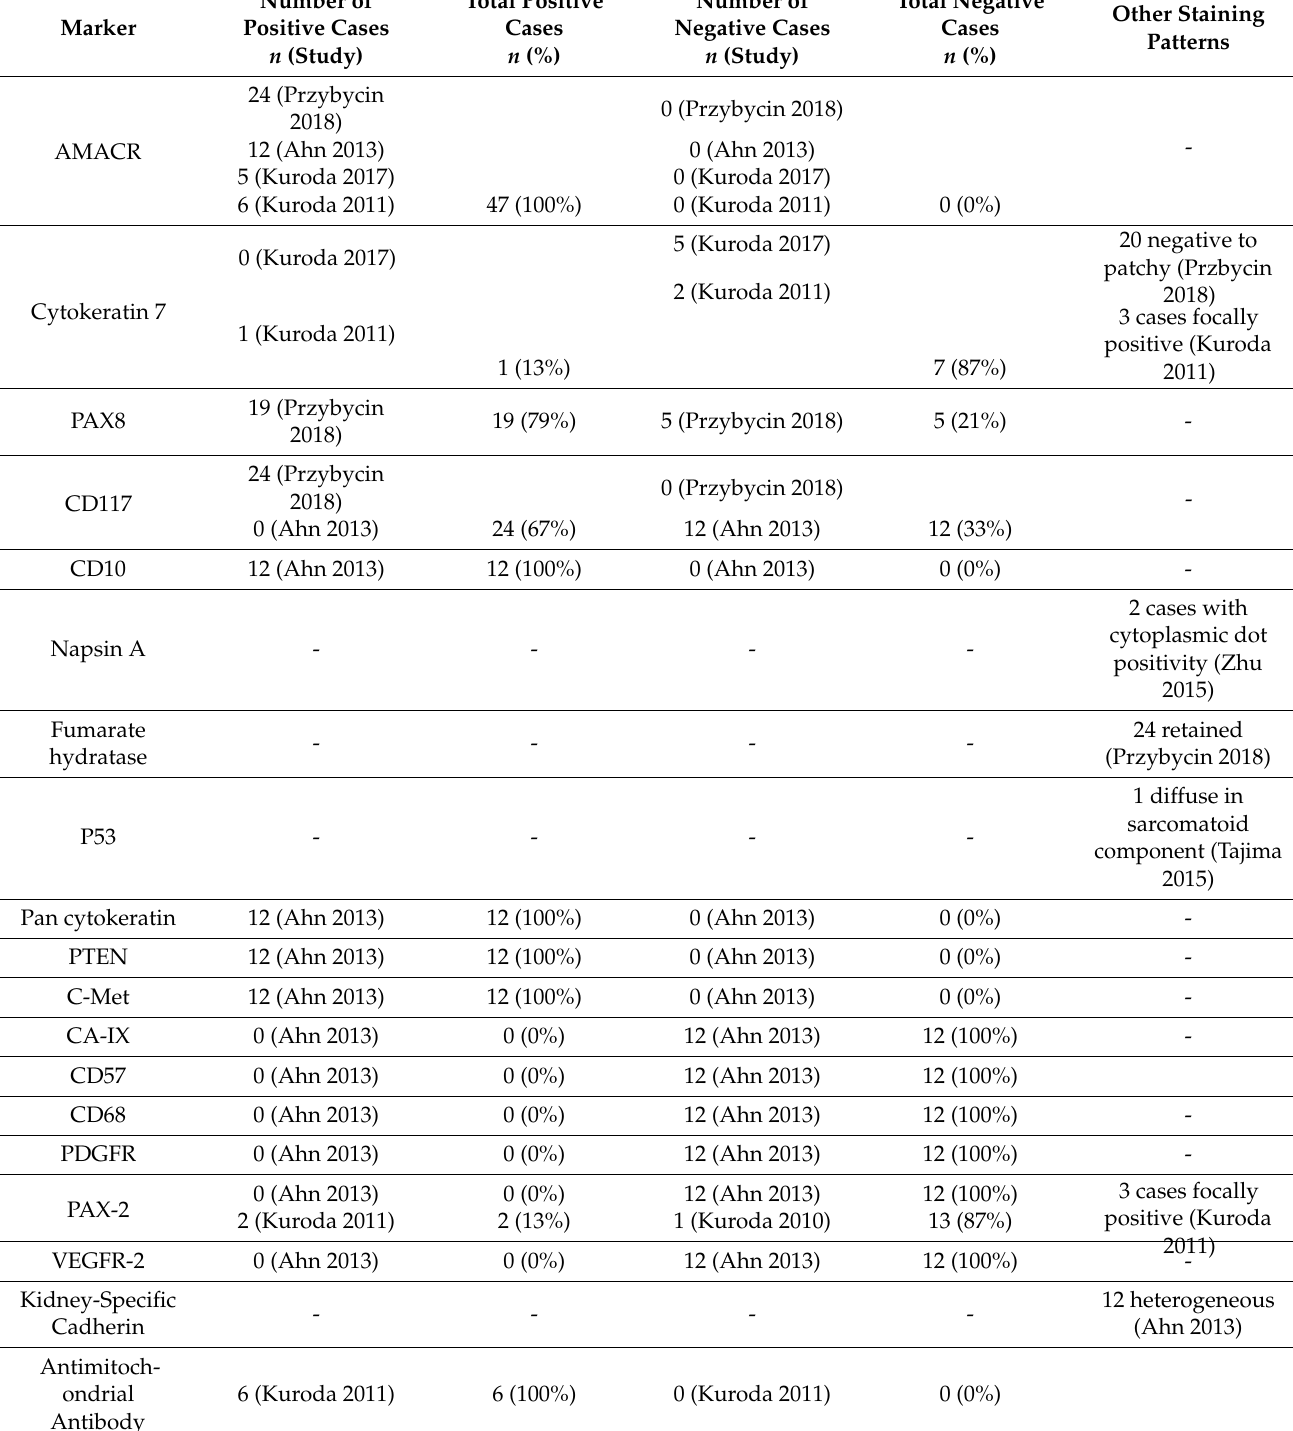
Table 3. Immunohistochemical markers in ACKD-RCC